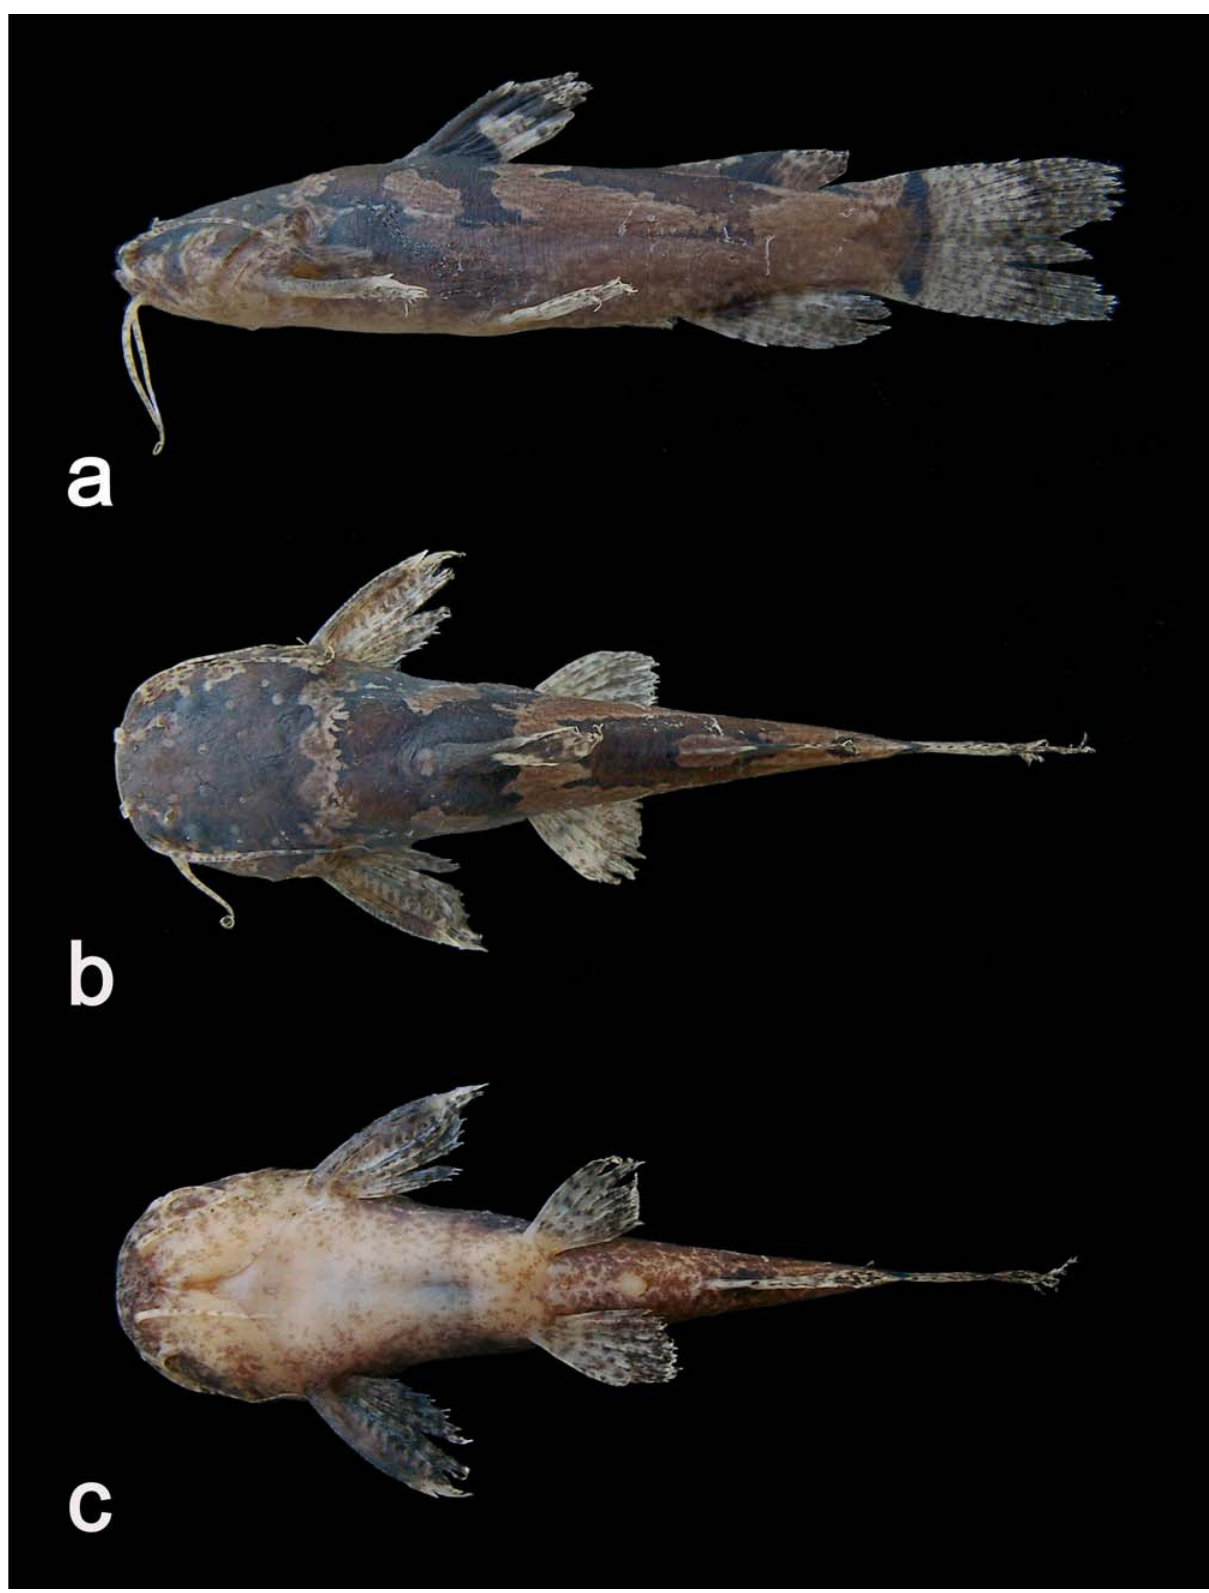
Fig. 1. Microglanis pataxo , holotype, MNRJ 28397, 39.0 mm SL, in a. lateral; b. dorsal; and c. ventral